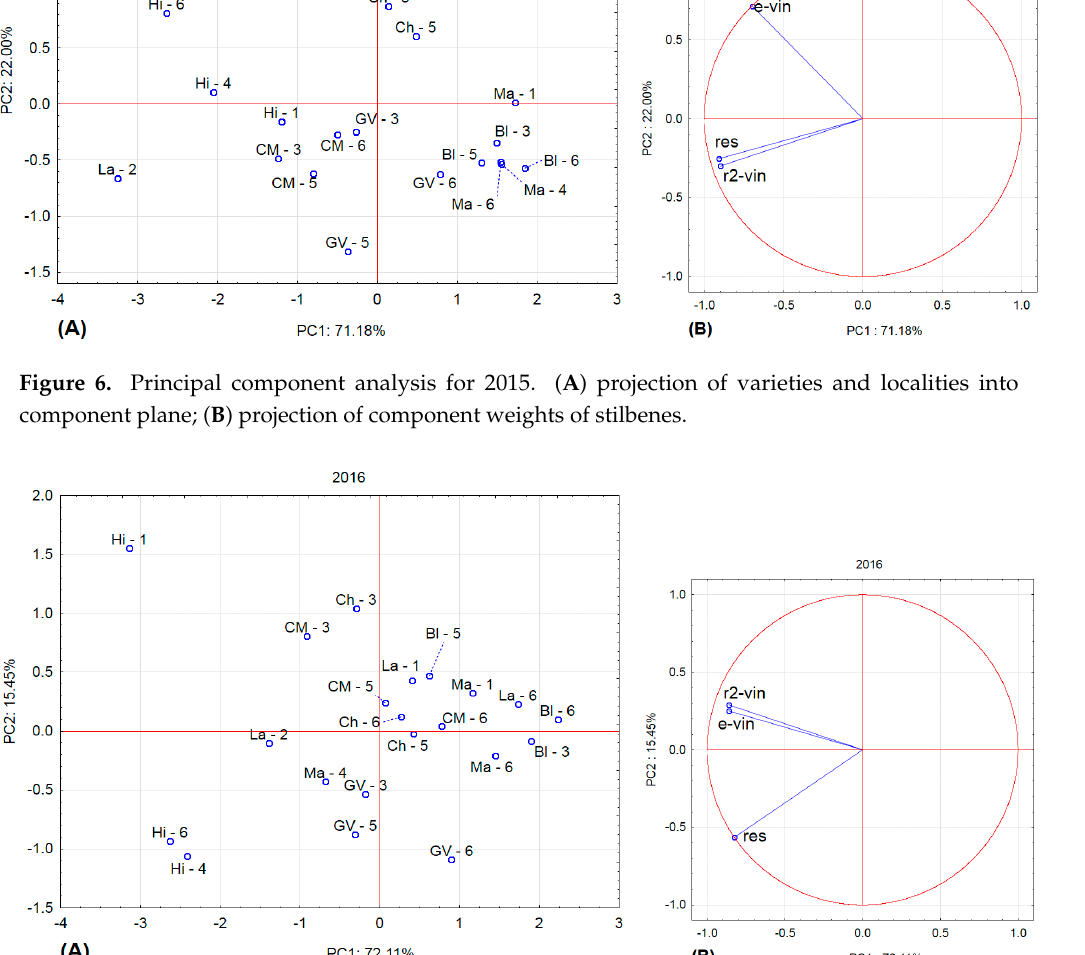
Figure 7. Principal component analysis for 2016. ( A ) projection of varieties and localities into component plane; ( B ) projection of component weights of stilbenes.